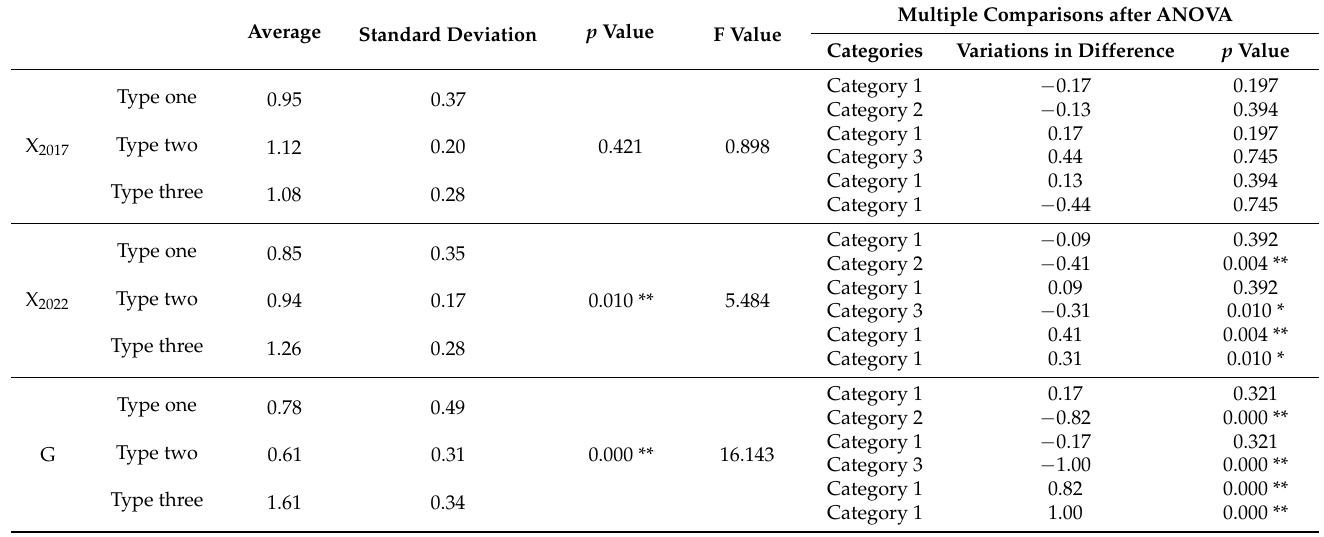
Table 3. Comparison of the housing rent in the three types of urban villages through ANOVA.